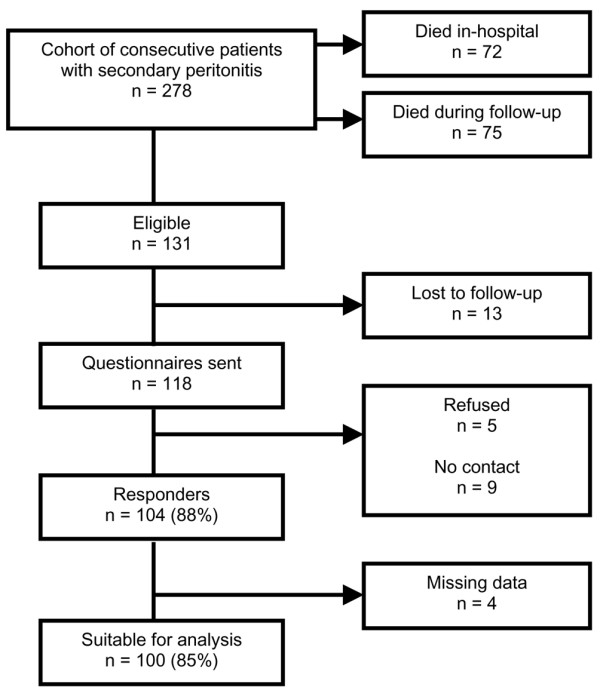
Flowchart of study inclusion.